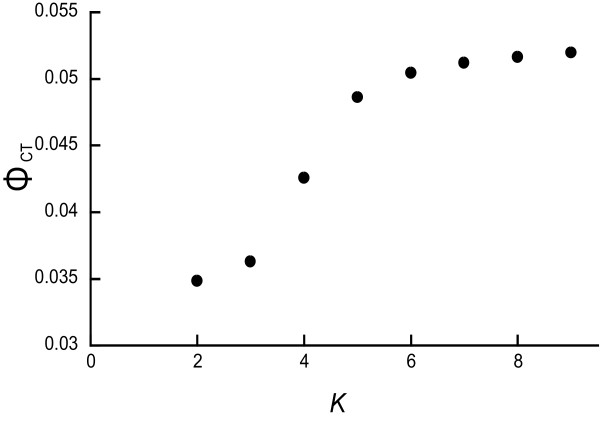
Plot of the ΦCT parameter for different values of K, the number of population groups generated using SAMOVA [39].